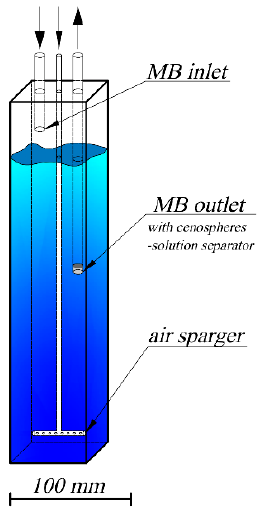
Figure 2. Laboratory system scheme.